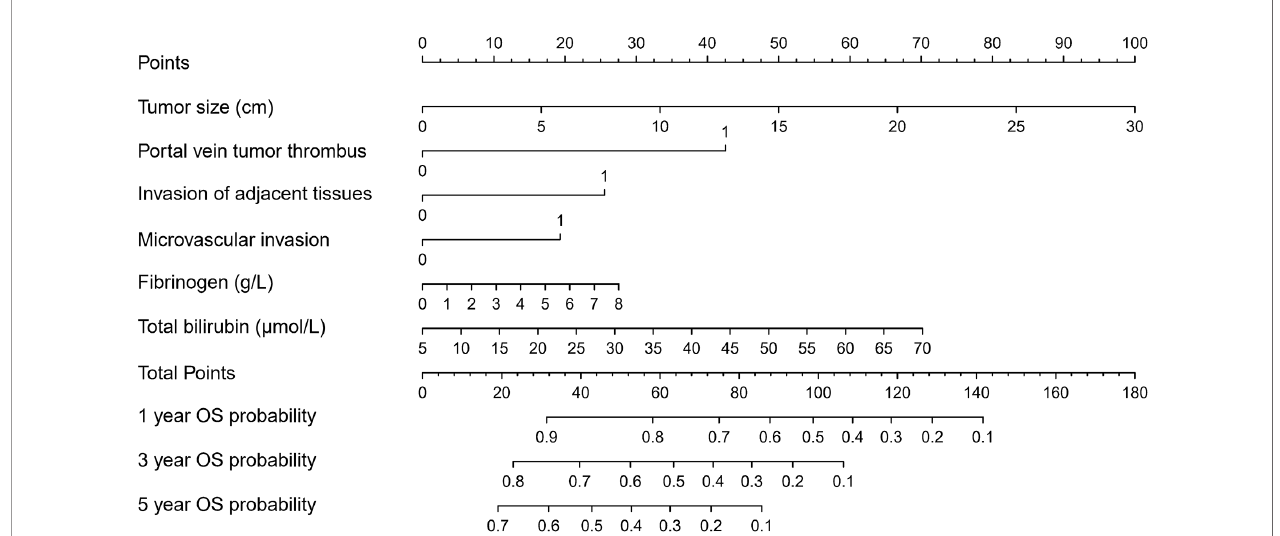
FIGURE 1 | Nomogram for predicting overall survival (OS) after curative resection of livers in patients with hepatocellular carcinoma (HCC).